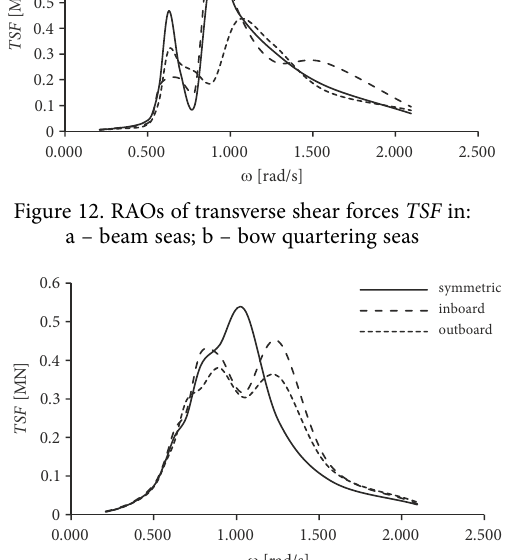
Figure 13. RAOs of transverse shear forces TSF in head